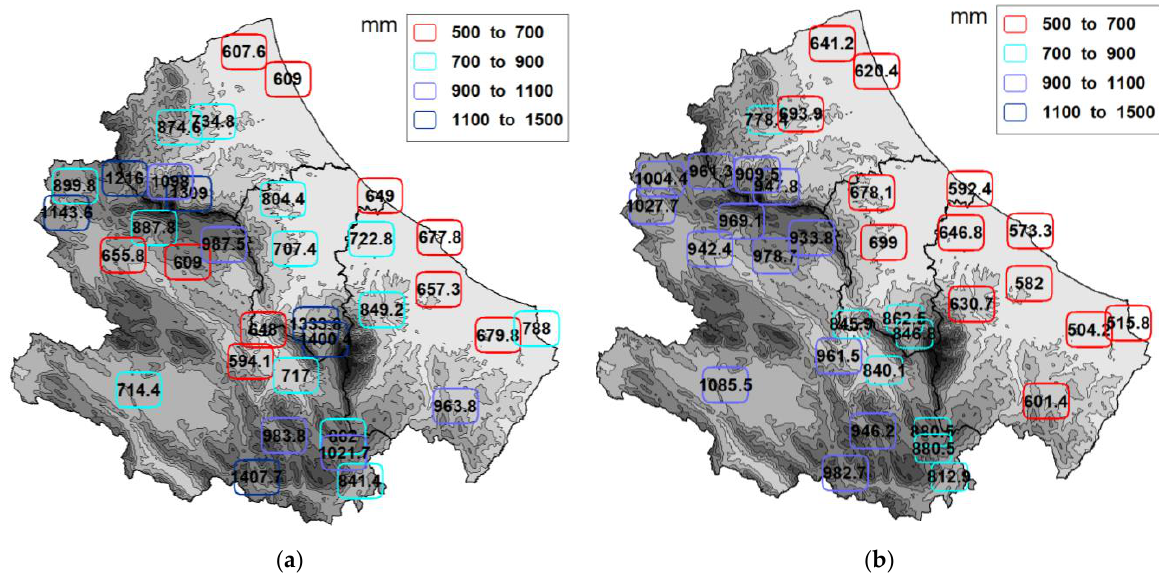
Figure 2. Spatial distribution of median annual rainfall amounts: ( a ) point data; ( b ) grid E-OBS data.